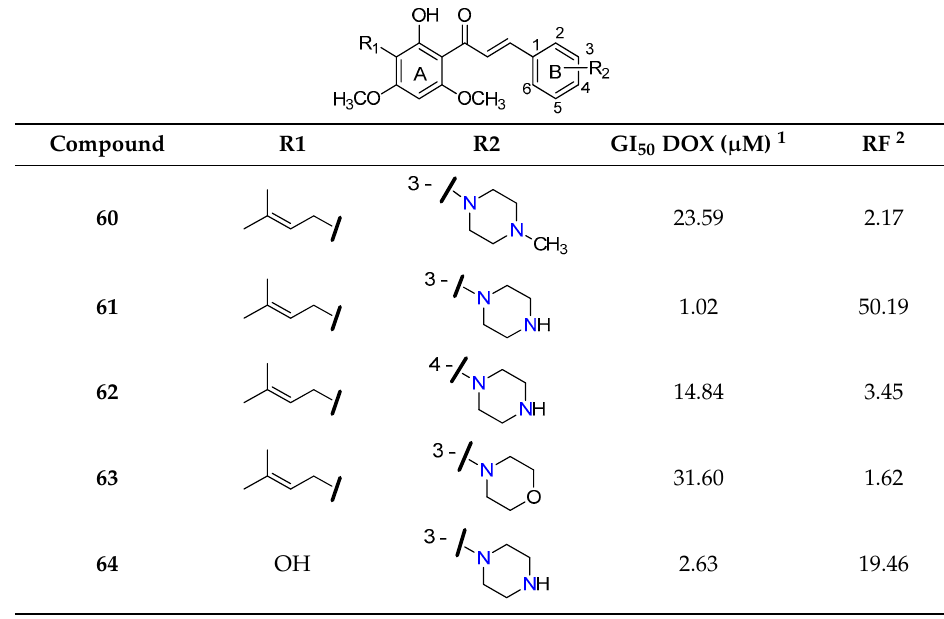
Table 4. Doxorubicin-resistance reversal effects of chalcone derivatives 60 – 64 at a concentration of